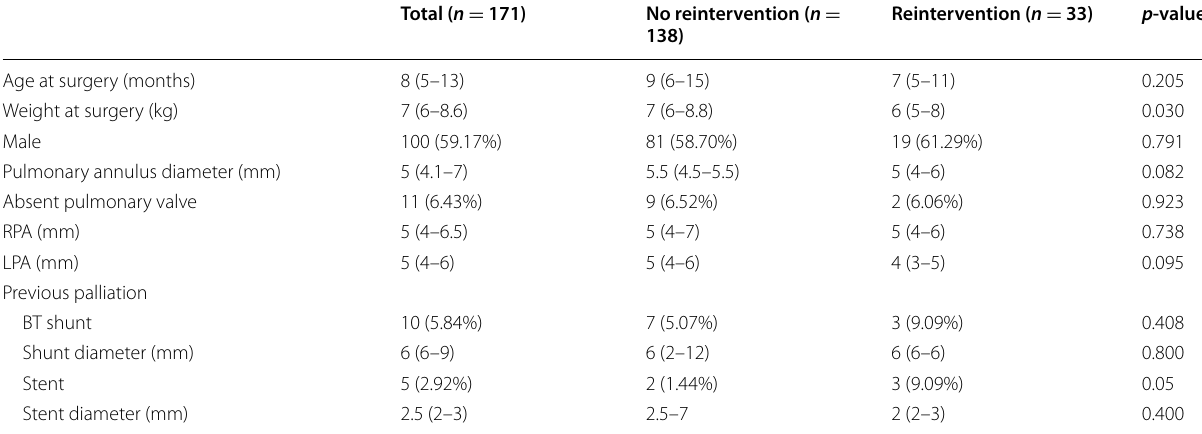
Table 1 Comparison of the baseline data between patients who had reintervention after tetralogy of Fallot repair vs. those who did not